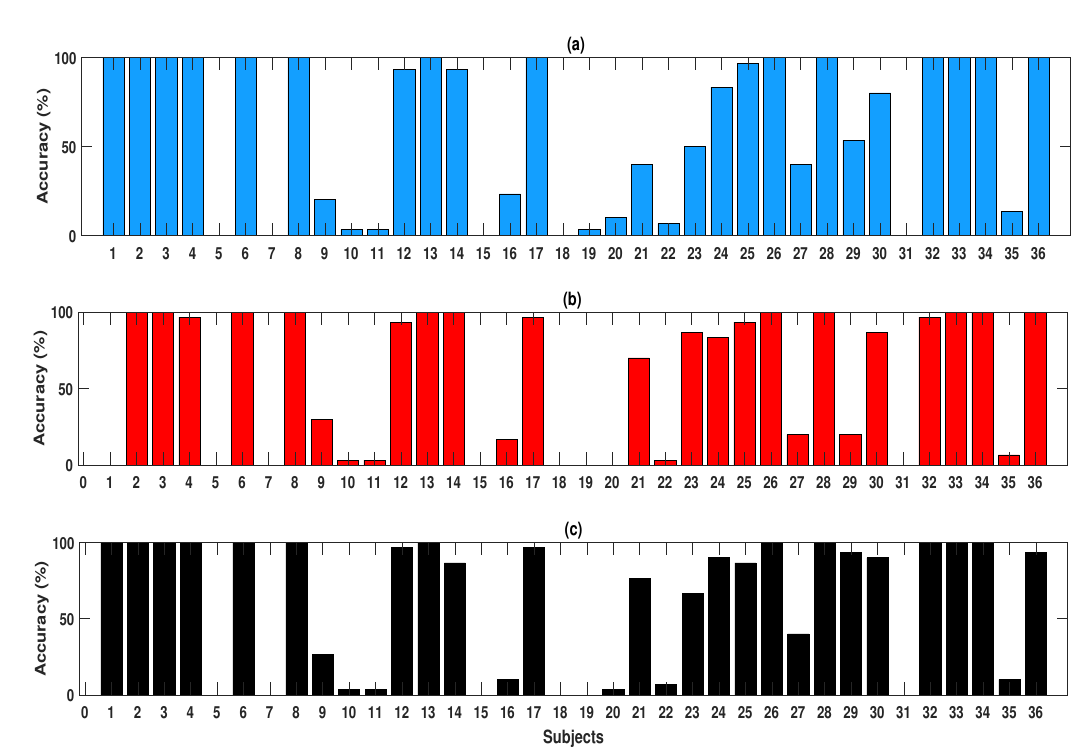
Figure 14. ( a ) Accuracy values obtained for the LSTM classifier using subject independent CV for the automated classification of teh BMAC vs. GMAC task. ( b ) Accuracy values obtained for the BLSTM classifier using subject independent CV for the automated classification of the BMAC vs. GMAC task. ( c ) Accuracy values obtained for the GRU classifier using subject independent CV for the automated classification of the BMAC vs. GMAC task.